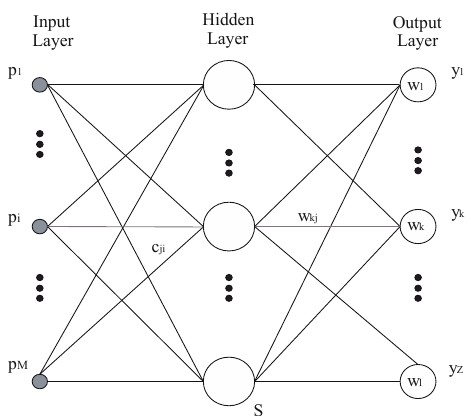
Figure 2. Structure of the proposed RBF network.